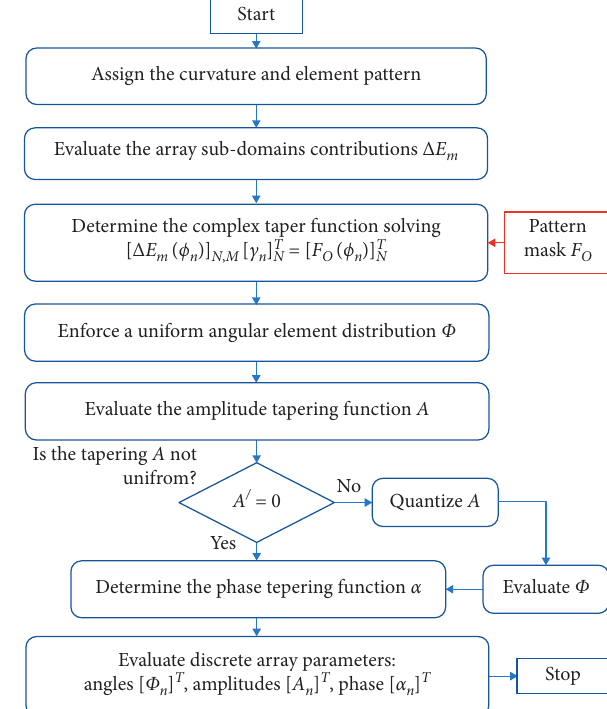
Figure 9: Diagram of the AAP technique for conformal array synthesis with constraints on the structure layout [58]. Figure 10: Diagram of the AAP technique for array synthesis with a quantization of the excitation amplitude